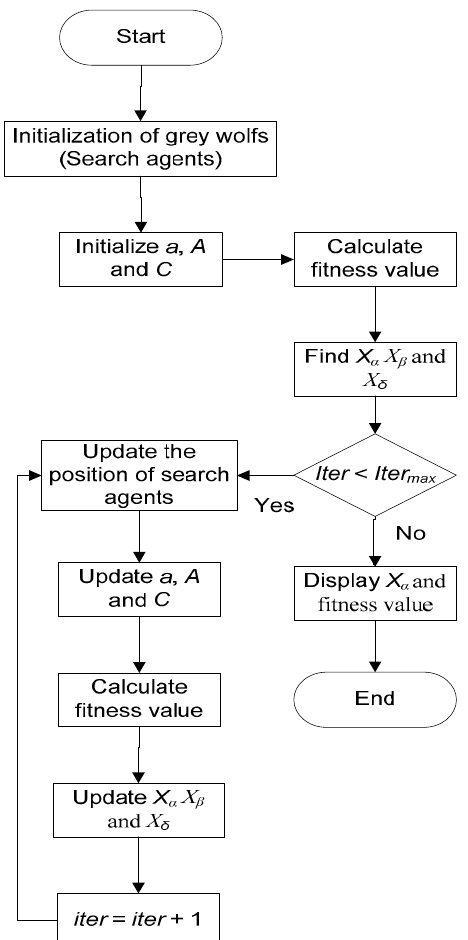
Figure 2. Flow chart of the grey wolf optimization (GWO) algorithm [30].